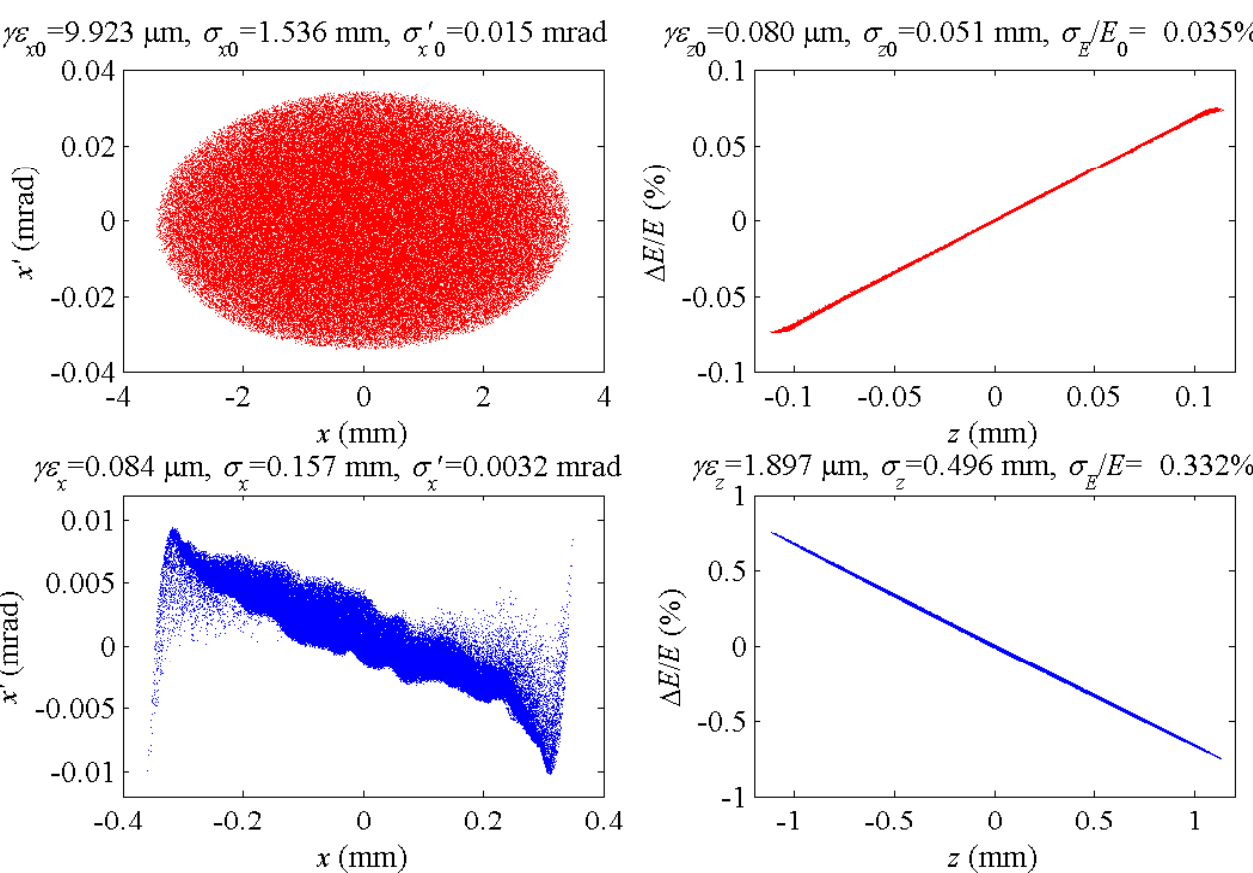
FIG. 4. (Color) Transverse phase space (left two plots) and longitudinal phase space (right two plots) before (top row) and after (bottom row) the emittance exchange as simulated with ELEGANT , using particles from the injector simulation, but not including CSR.